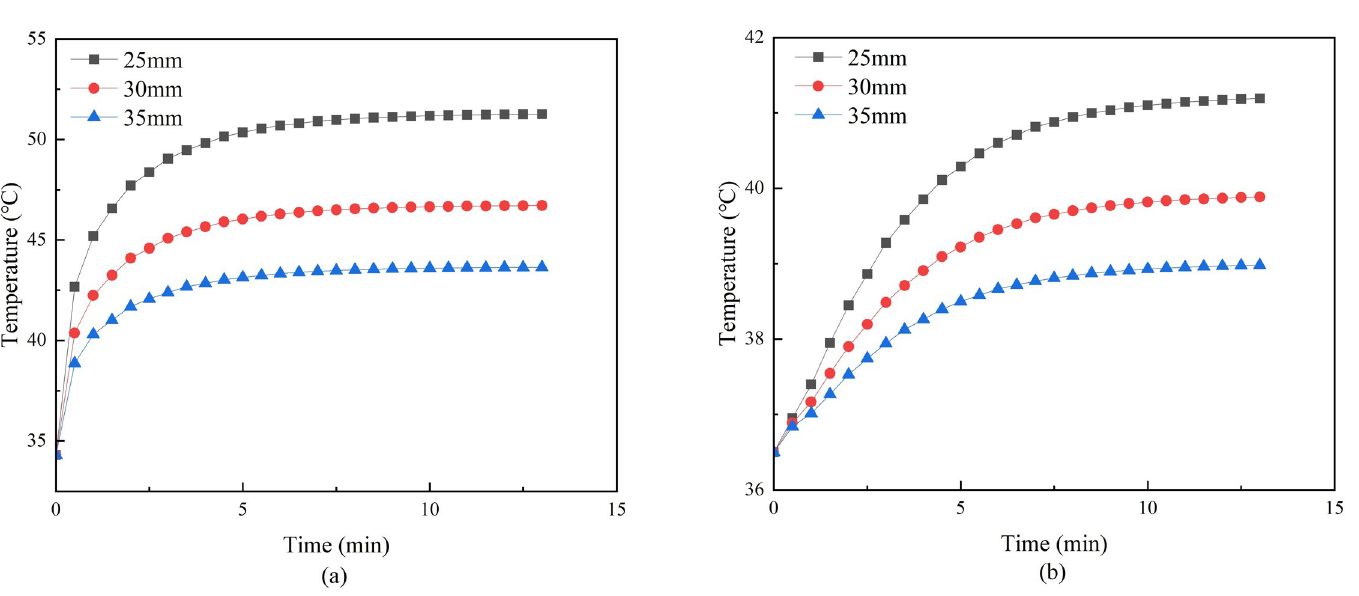
Fig 9. (a) Temperature curve of moxa point at different distances from the skin. (b) Temperature curve at 5mm under moxa point at different distances from the skin.